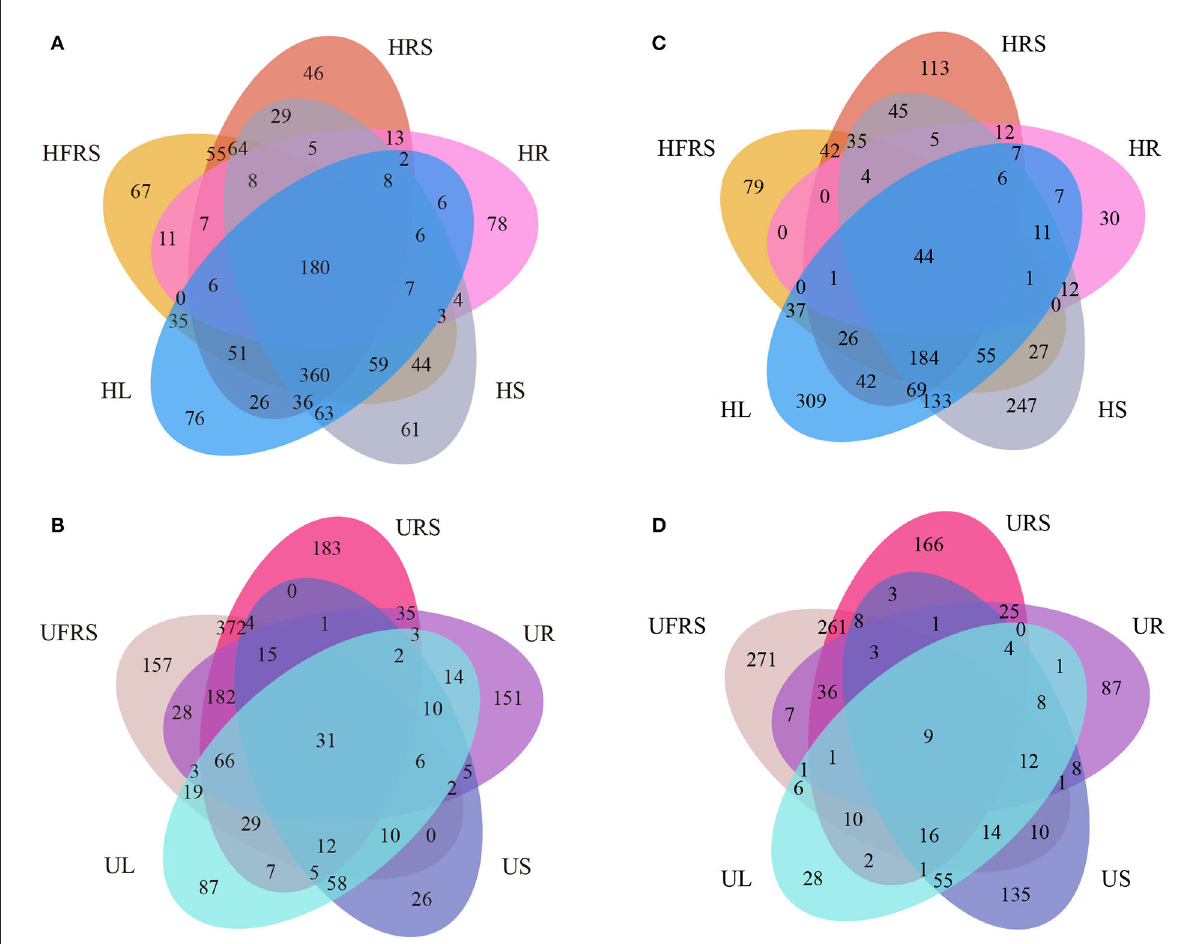
FIGURE4 Venn diagrams depicting the unique and shared (A,B) bacterial and (C,D) fungal OTUs in different compartments of P. bungeana . Venn diagram depicting the bacterial OTUs in different niches of (A) healthy and (B) unhealthy P. bungeana plants. Venn diagram depicting the fungal OTUs in different niches of (C) healthy and (D) unhealthy P. bungeana plants. Abbreviations of variables are given in Figure